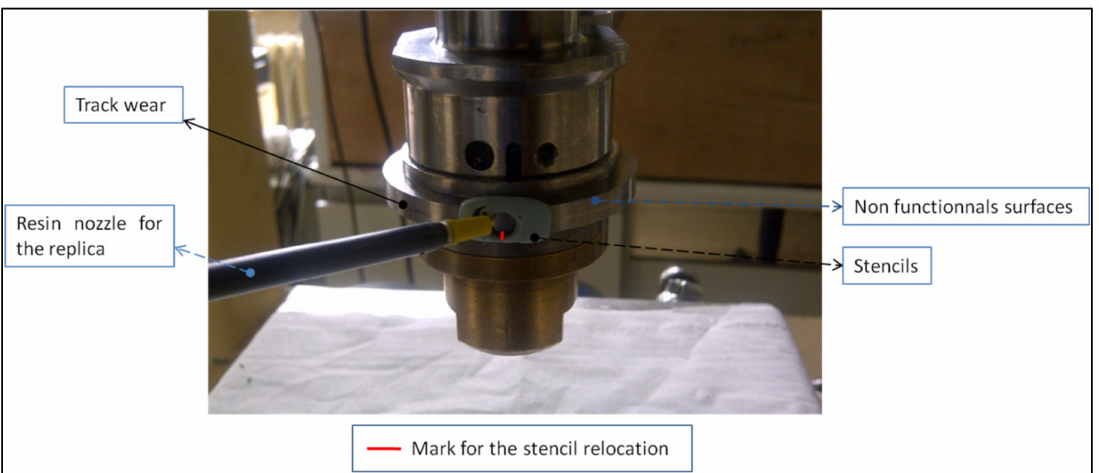
Figure 2. Replica